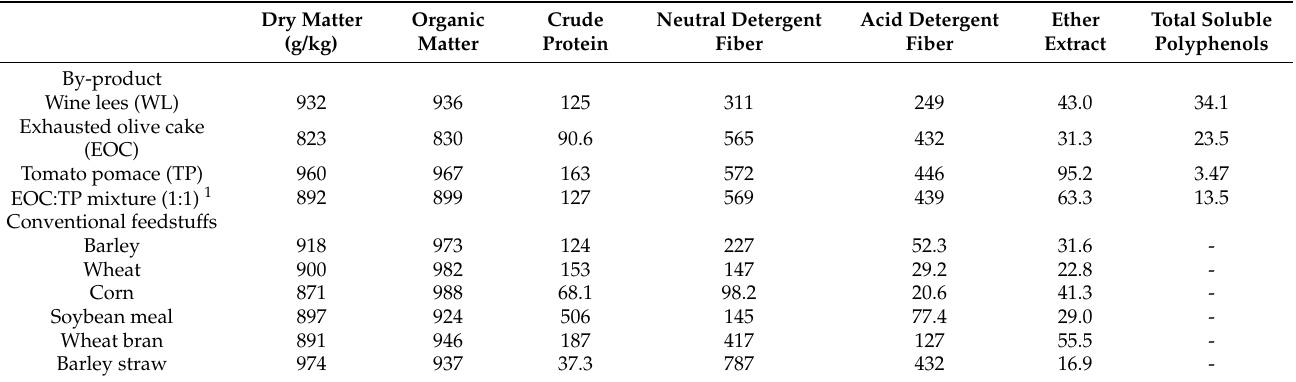
Table 1. Chemical composition (g/kg dry matter (DM) unless stated otherwise) of by-products and feedstuffs used to formulate the experimental diets.